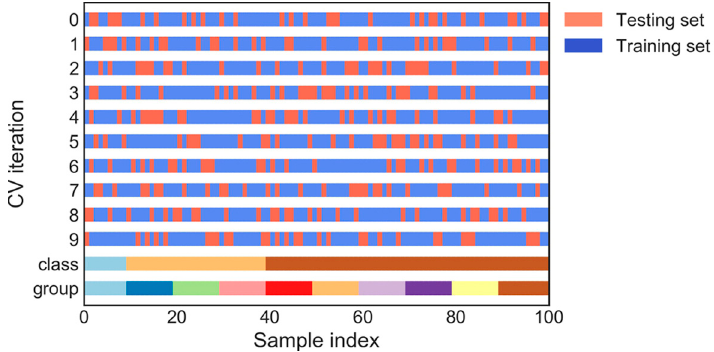
Figure 7. Generation of the cross-validation dataset.